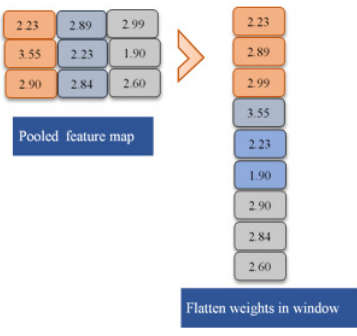
Figure 9. Flatten layer.